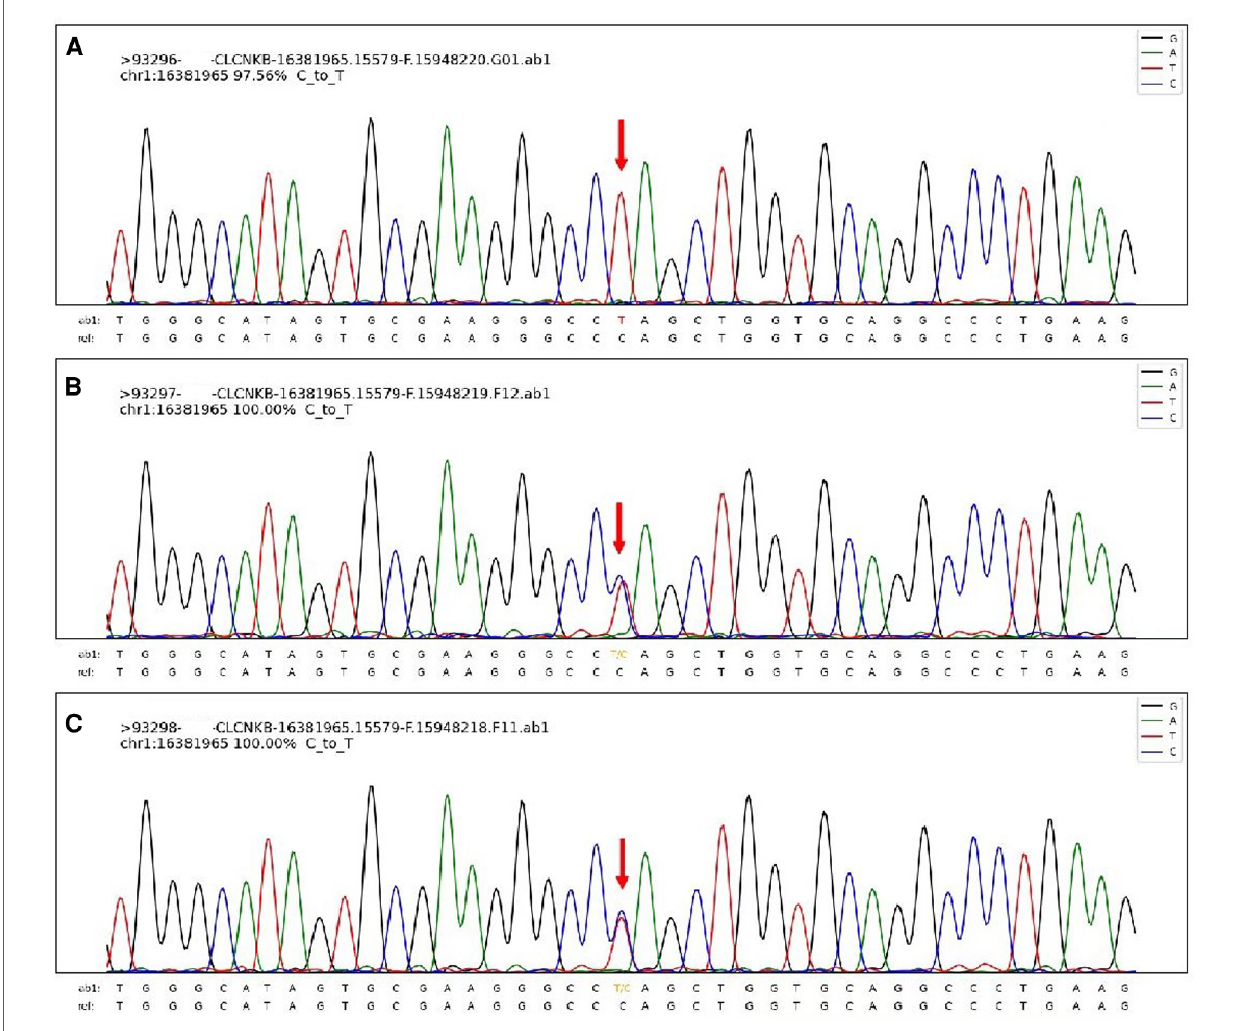
FIGURE 3 The sanger sequencing map of this patient ’ s family. The patient ’ s homozygous variation CLCNKB gene, which was c.1792C>T ( p . Q598*) ( A ) and the sanger results of his parents ( B,C